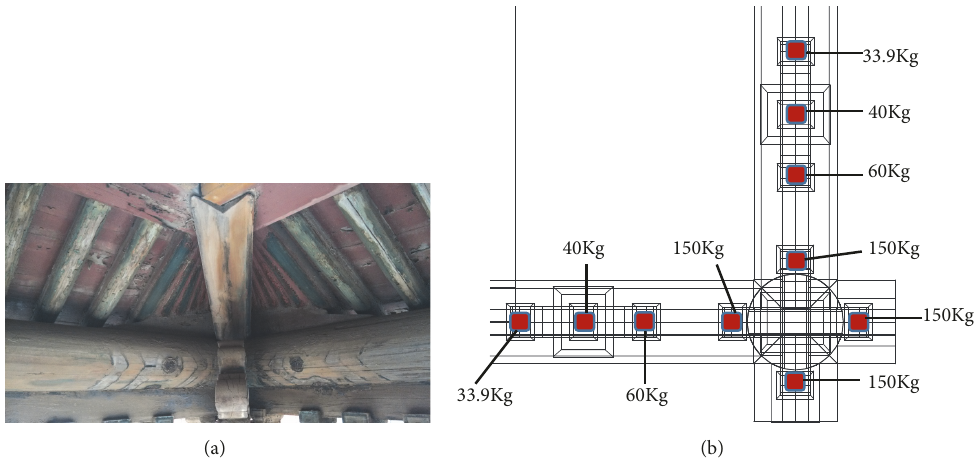
Figure 14: Roof of the structure: (a) picture of roof at corner; (b) simplification of roof mass distribution.